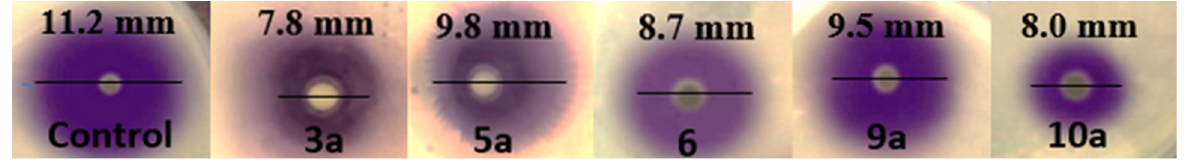
Figure 6. Anti-QS activity via signal inhibition in P. aeruginosa . Control well, QS signals produced exogenously and diffused through P. aeruginosa ; these molecules were traced with purple pigmentation, produced by CV026 in Soft Top agar. In the presence of the sub-MICs of the compounds 3a , 5a , 6 , 9a , and 10a , bacterial culture (10 6 CFU/mL) was used, and the QS signal diffusion zone was decreased compared with the control well (mean ± SD, p < 0.05).